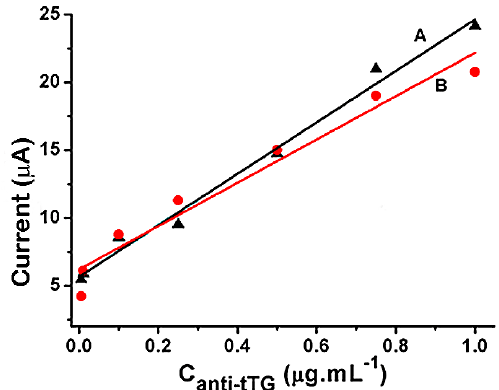
Figure 4. Calibration curves for the current recorded at 0.32 V vs. anti tTG concentration, obtained with the TGNEE–Anti-tTG–secAb-HRP immunosensor using approach ( A ) with the CV recorded in the potential window of Figure 3A or approach ( B ) with the CV recorded in the potential window of Figure 3B.